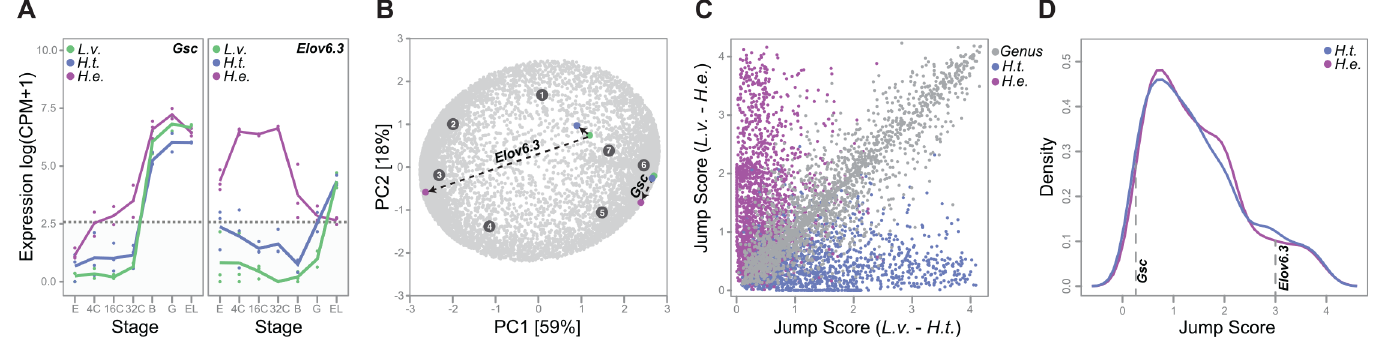
Fig 3. Subtle shifts are more common than dramatic changes in gene expression between species. (A) Along the H . erythrogramma branch, Gsc displays a subtle change in expression and is slightly accelerated compared to the planktotrophs. Accordingly, Gsc is assigned to cluster 6 in the planktotrophs and cluster 5 in H . erythrogramma . In contrast, Elov6 . 3 exhibits a dramatic change in expression and is assigned to cluster 7 in the planktotrophs and cluster 3 in the lecithotroph. Biological replicates are represented as circles, and average expression profiles across replicates are represented as lines. Expression values below the horizontal line are less than 5 counts per million (cpm) and are designated as VLE (S1 Data). (B) In the PCA plot, each ortholog is a light grey circle and each cluster centroid is a dark grey circle. The PCA was performed on S3 Data (see Methods). To calculate a jump score from the L . variegatus ortholog of Elov6 . 3 (green circle) to the H . erythrogramma ortholog of Elov6 . 3 (purple circle), we calculated a scaled distance, or “ jump score, ” from the first two PC loadings (see Methods). This calculation was repeated to obtain the distance between the L . variegatus and the H . tuberculata ortholog (blue circle). The position of Gsc orthologs for each species is also shown. All profiles designated as VLE have the coordinates (0,0). (C) Distribution of jump scores calculated from L . variegatus to H . tuberculata ( x -axis) and from L . variegatus to H . erythrogramma ( y -axis) (S4 Data). Jump scores are colored according to comparative clustering classification: H . erythrogramma branch jumps are purple, H . tuberculata branch jumps are blue, and genus level changes are grey. For clarity, jump score distributions of conserved and diverged genes are plotted separately in S3 Fig. (D) Kernel density curves of jump scores for genes that exhibited a cluster jump in either H . tuberculata (blue) or H . erythrogramma (purple) (S4 Data).